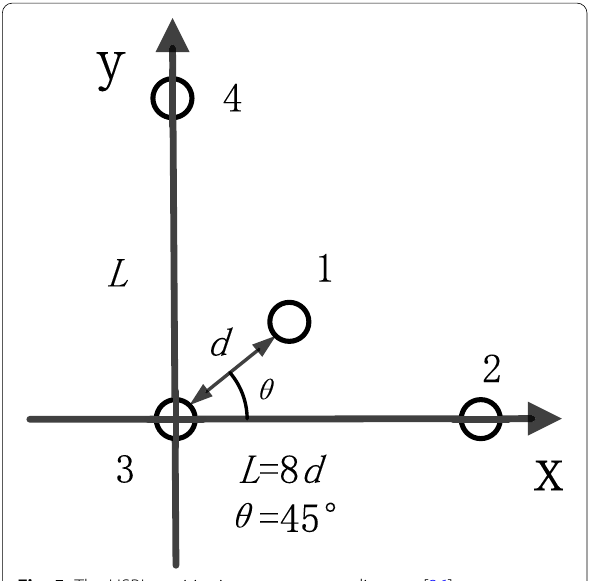
Fig. 5 The USBL positioning system array diagram